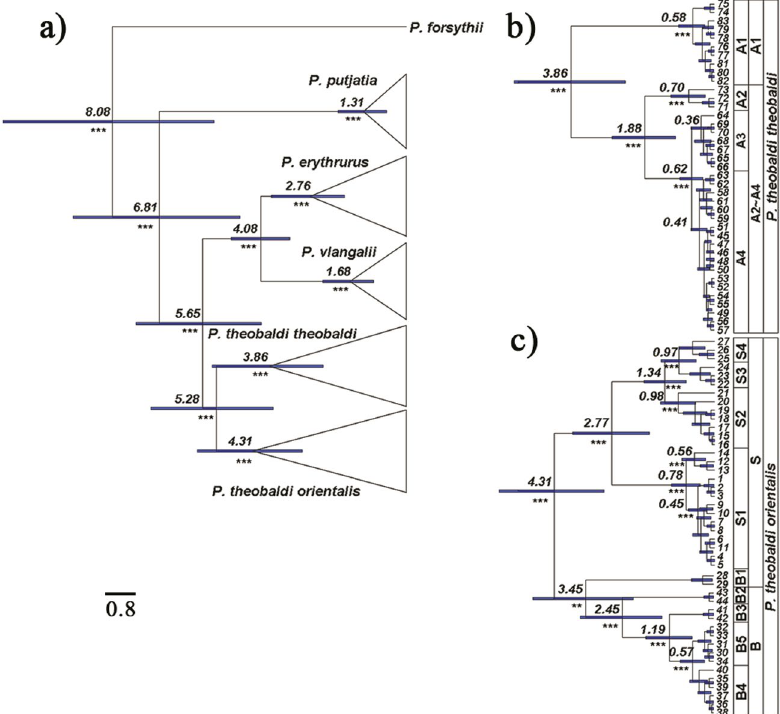
Figure 2. The Bayesian tree on the left (Fig. 2a) shows divergence times across related Phrynocephalus species ( P. forsythii , P. vlangalii , P. erythrurus , P. putjatia and P. theobaldi ), as obtained from Bayesian dating analyses. Higher resolution detail of relationships and divergence times among numbered haplotypes within the two P. theobaldi clades of interest are shown on the right (Fig. 2b and c). Values on nodes are posterior mean divergence times, bars represent the 95% HPDs for these times. Time-calibrated nodes are denoted by #. Posterior node support values for nodes that were not constrained to be monophyletic are given as asterisks: * > 0.75, ** > 0.90, *** > 0.95.